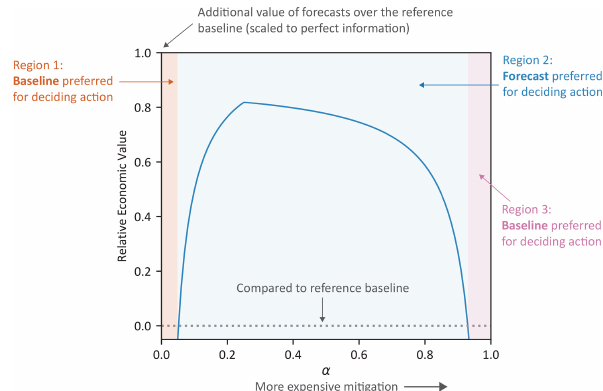
Figure 1. Illustrative value diagram with key features annotated with three key regions of α noted. Positive REV for users in re- gion 2 indicates the forecasts should be preferred to the baseline when making the decision under analysis. Negative REV for users in region 1 and 3 indicates the baseline should be